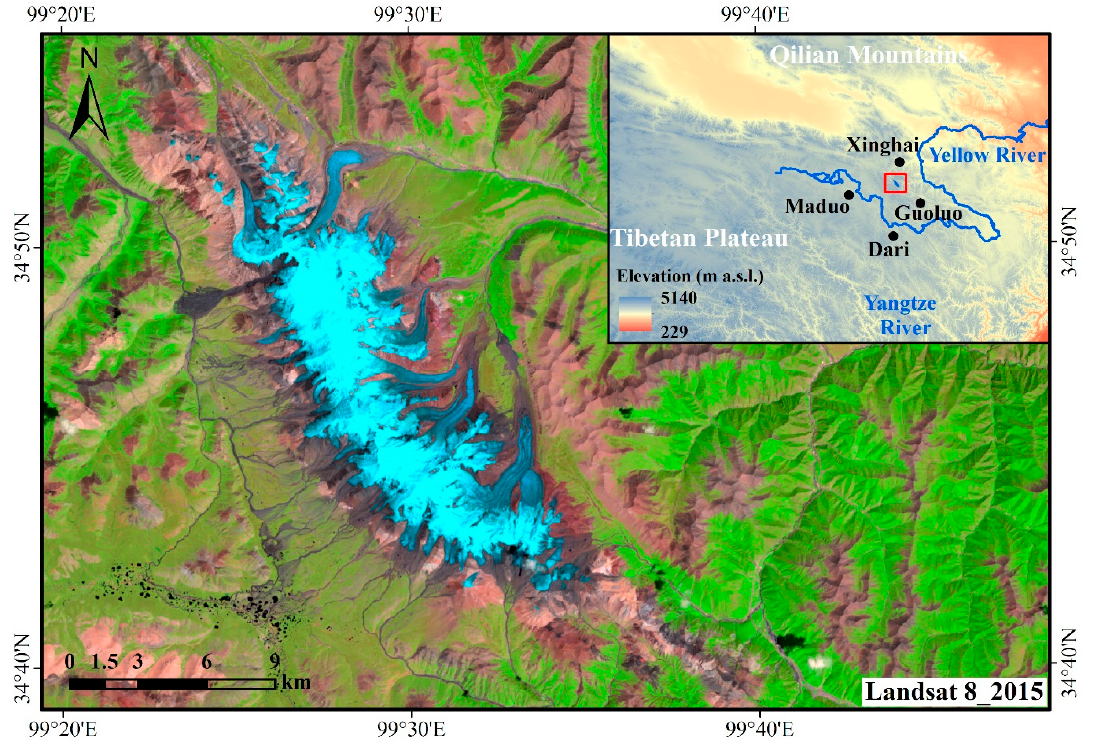
Figure 1. Map showing the study area and the distribution of glaciers.